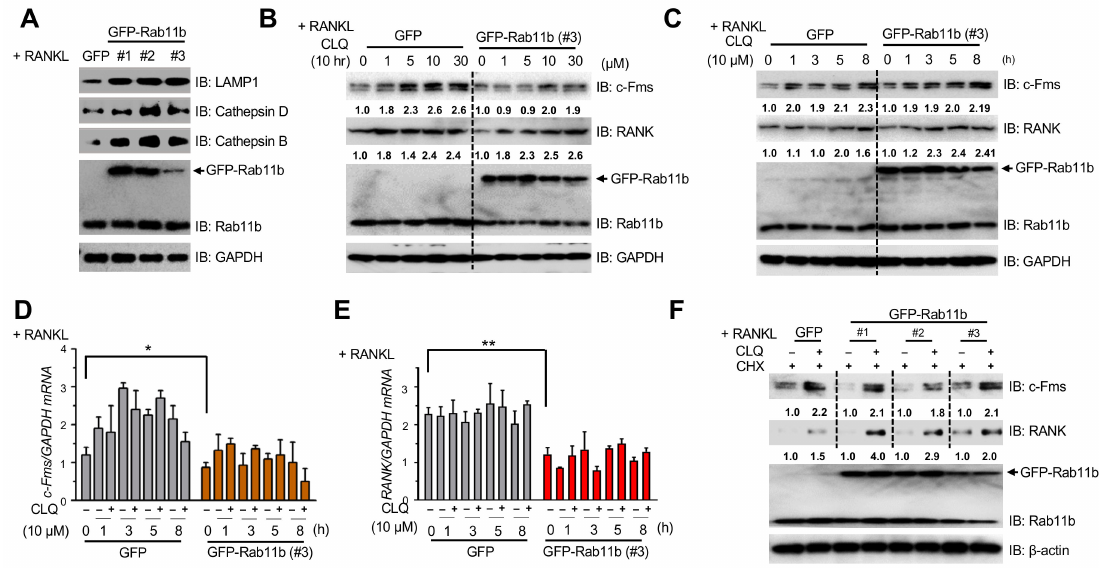
Figure 6. The e ff ects of CLQ-mediated lysosomal function on endogenous levels of c-Fms and RANK in RAW-D cell-derived osteoclasts. ( A ) RAW-D cells expressing GFP or one of three di ff erent types